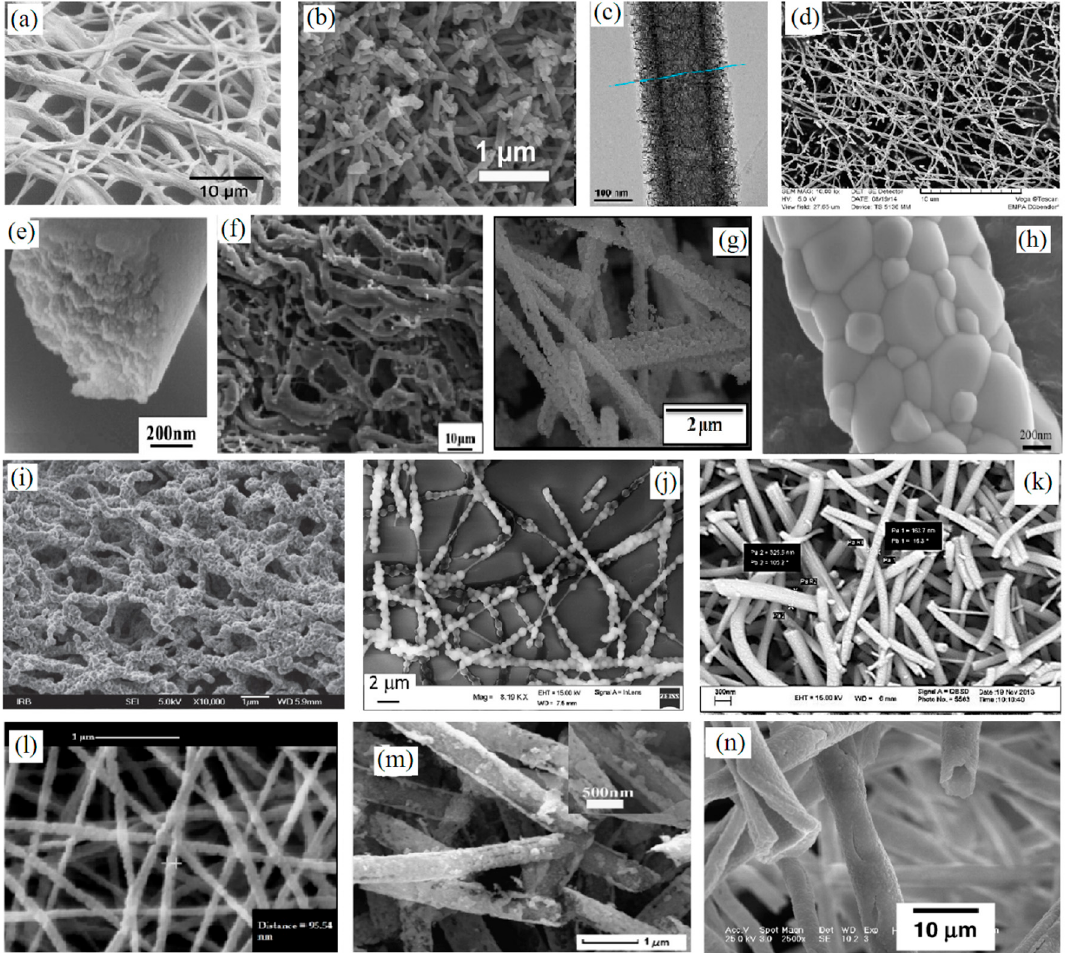
Figure 7. Micrographs of ceramic fibers synthesized by electrospinning method. ( a ) HA NFs calcined at 700 ◦ C. Reprinted with permission from Ref. [40]; ( b ) Pr 0.4 Sr 0.6 Co 0.2 Fe 0.7 Nb 0.1 O 3 − δ NFs calcined at 800 ◦ C. Reprinted with permission from Ref. [55]; ( c ) MnO 2 NFs calcined at 1000 ◦ C. Reprinted with permission from Ref. [29]; ( d ) CaCu 3 Ti 4 O 12 NFs calcined at 900 ◦ C. Reprinted with permission from Ref. [97]; ( e ) Al 2 O 3 NF calcined at 800 ◦ C. Reprinted with permission from Ref. [24]; ( f ) BaFe 12 O 19 NFs calcined at 800 ◦ C. Reprinted with permission from Ref. [25]; ( g ) CdTiO 3 NFs calcined at 600 ◦ C. Reprinted with permission from Ref. [32]; ( h ) La 2 Zr 2 O 7 NFs calcined at 1400 ◦ C. Reprinted with permission from Ref. [46]; ( i ) NiO NFs calcined at 400 ◦ C. Reprinted with permission from Ref. [52]; ( j ) SiO 2 NFs calcined at 400 ◦ C. Reprinted with permission from Ref. [56]; ( k ) TiO 2 NFs calcined at 500 ◦ C. Reprinted with permission from Ref. [68]; ( l ) Mullite NFs calcined at 1200 ◦ C. Reprinted with permission from Ref. [49]; ( m ) ZrC NFs after pyrolysis at 1400 ◦ C. Reprinted with permission from Ref. [78]; and ( n ) 8YSZ NFs calcined at 1400 ◦ C. Reprinted with permission from Ref. [81].